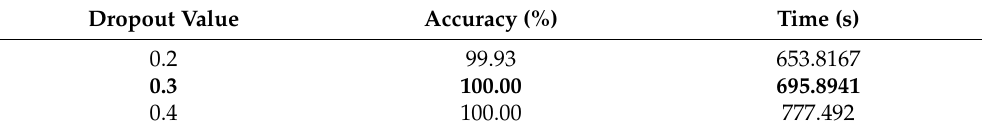
Table 5. Accuracy at different dropout rates P [ B = 32, L = 0.0001, θ = Adam].